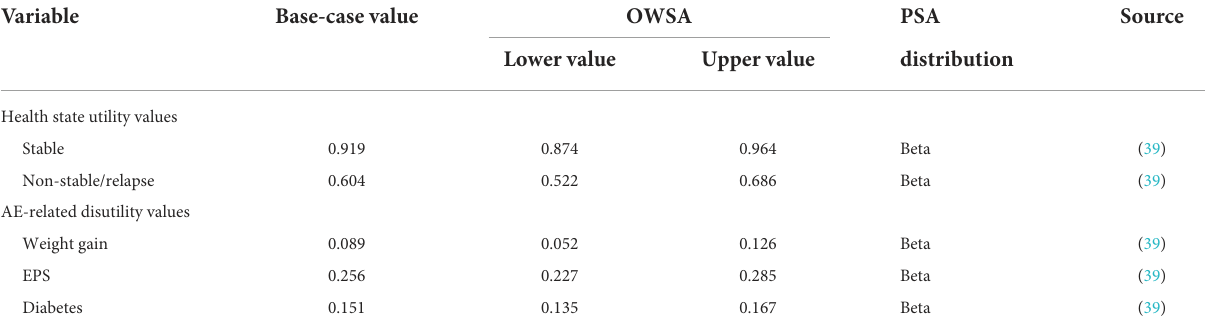
TABLE 3 Summary of utility data used in the